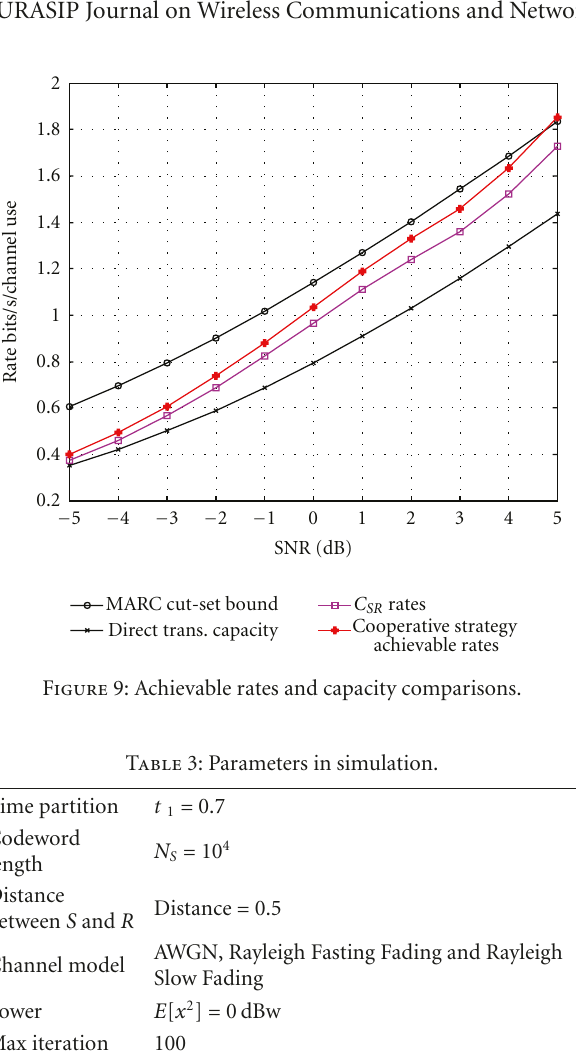
plotted in Figure 13. The comparisons show that increasing d increases the performance of BER versus SNR. This is because the path loss of the RD channel decreases, which , resulting in decoding of the extra is easier to decode C t 2 R check bits with a lower error rate. However, from Figure 5 in Section 3.1, when d = 0 . 5, the achievable sum-rate is optimal; the slope of the curve with d > 0 . 5 is larger than that of the curve with d < 0 . 5. In other words, as d = 0 .